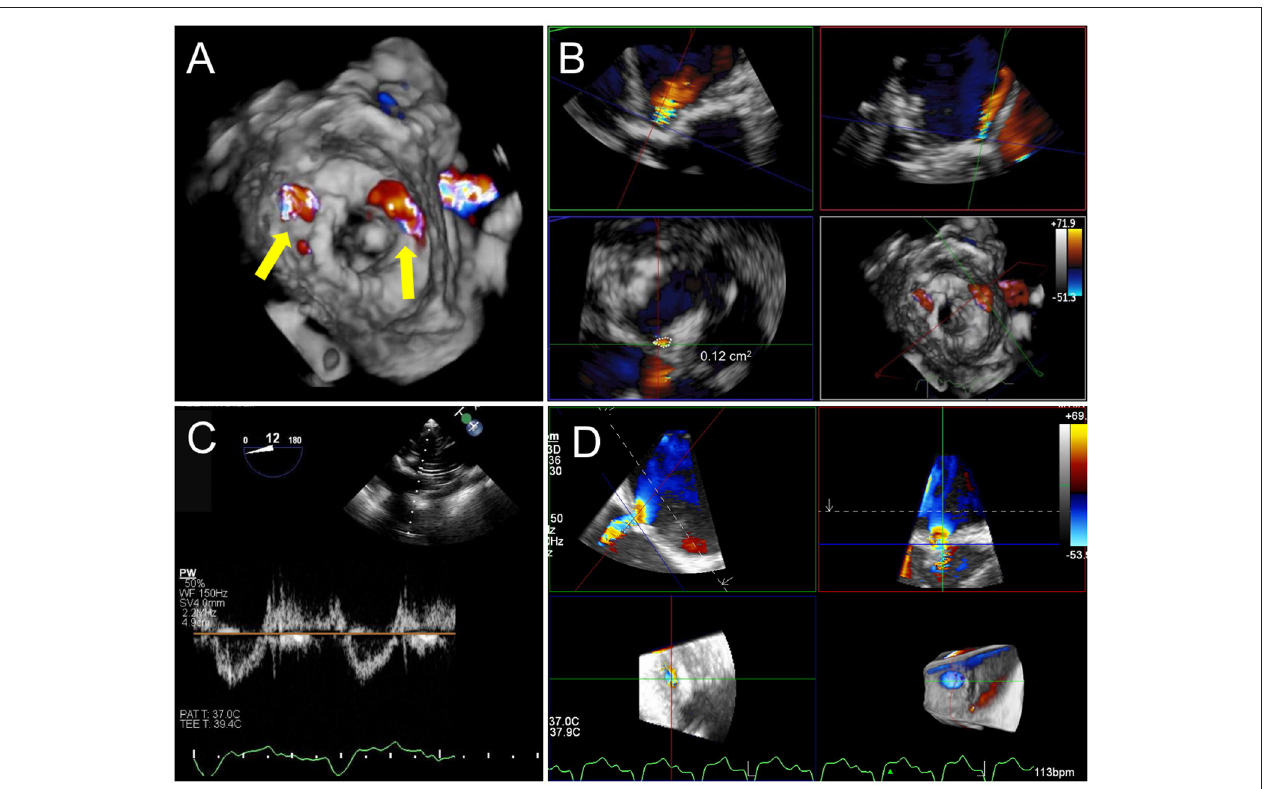
FIGURE 10 | Post TMVR assessment immediately after deployment. (A) 3D color Doppler evaluation from an en-face surgeon’s view immediately after a valve in MAC implantation reveals two areas of paravalvular leak (PVL) at 10 and 1 o’clock (yellow arrows). See Supplementary Video 3 for 3D en face evaluation of valve morphology and leaflet motion. (B) Careful interrogation of the largest area of PVL with 3D MPR reveals a vena contracta area of 0.12 cm2. (C) Pulsed-wave Doppler interrogation of the LVOT from a transgastric view in order to exclude a significant gradient or obstruction. (D) Evaluation of residual iatrogenic septal defect size and direction of